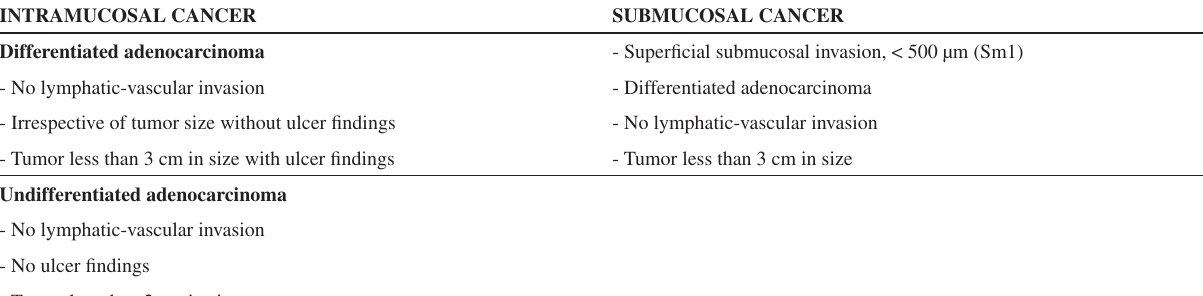
Table 1 - Indication criteria adopted for gastric cancer endoscopic submucosal resection.